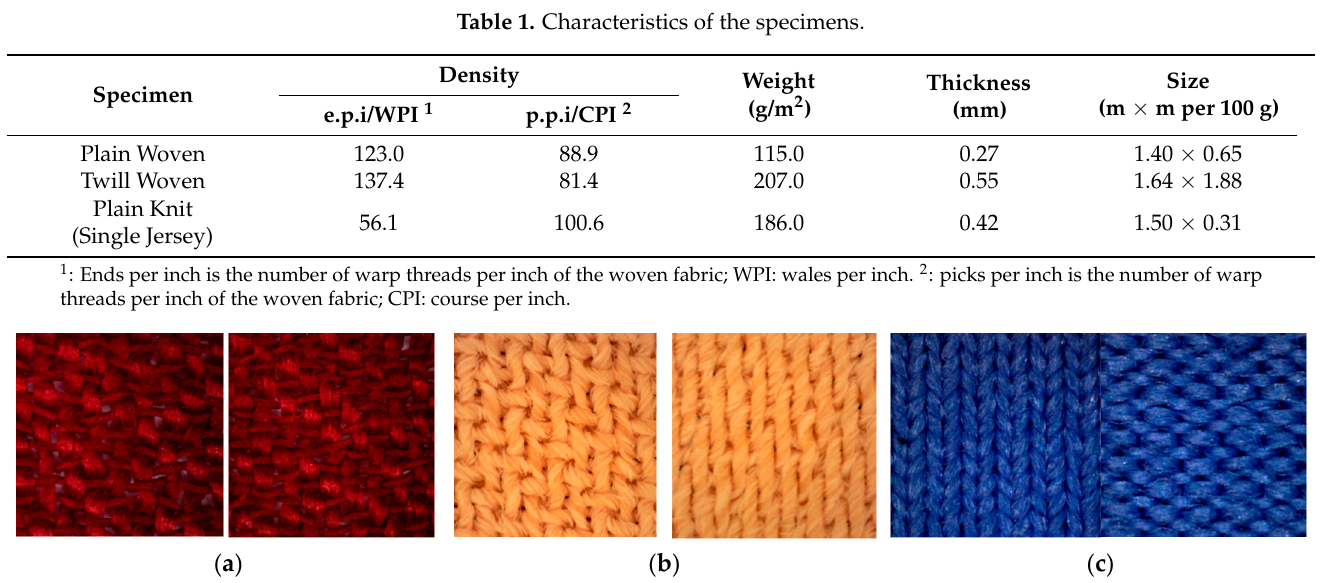
Table 1. Characteristics of the specimens.